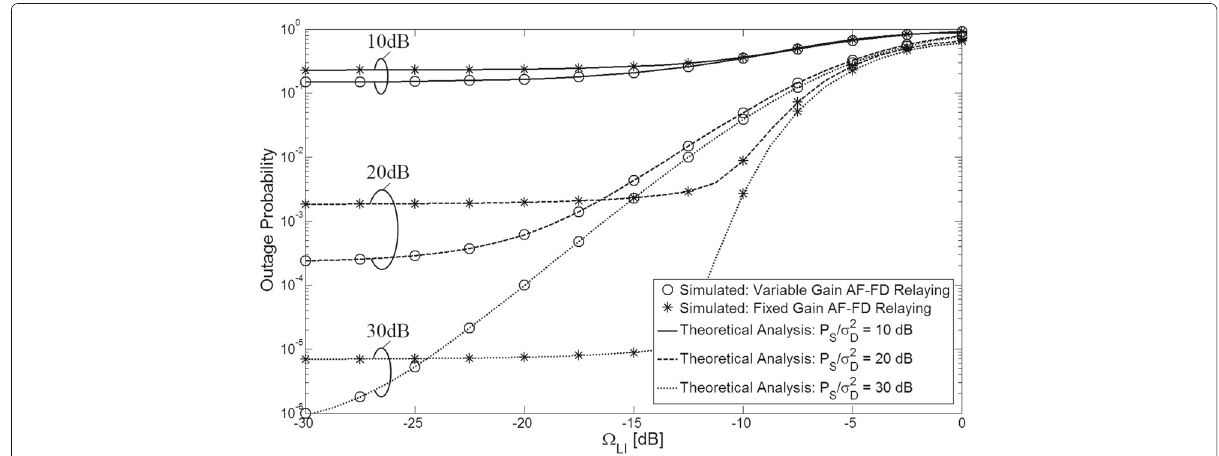
Fig. 6 Outage probability of the fixed-gain and variable-gain AF-FD systems for m SR = 3, m RD = m LI = 2.5 and γ th = 2